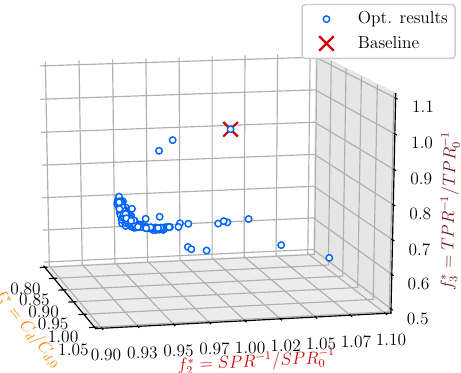
Figure 14. Baseline-scaled Pareto fronts concerning the tri-objective